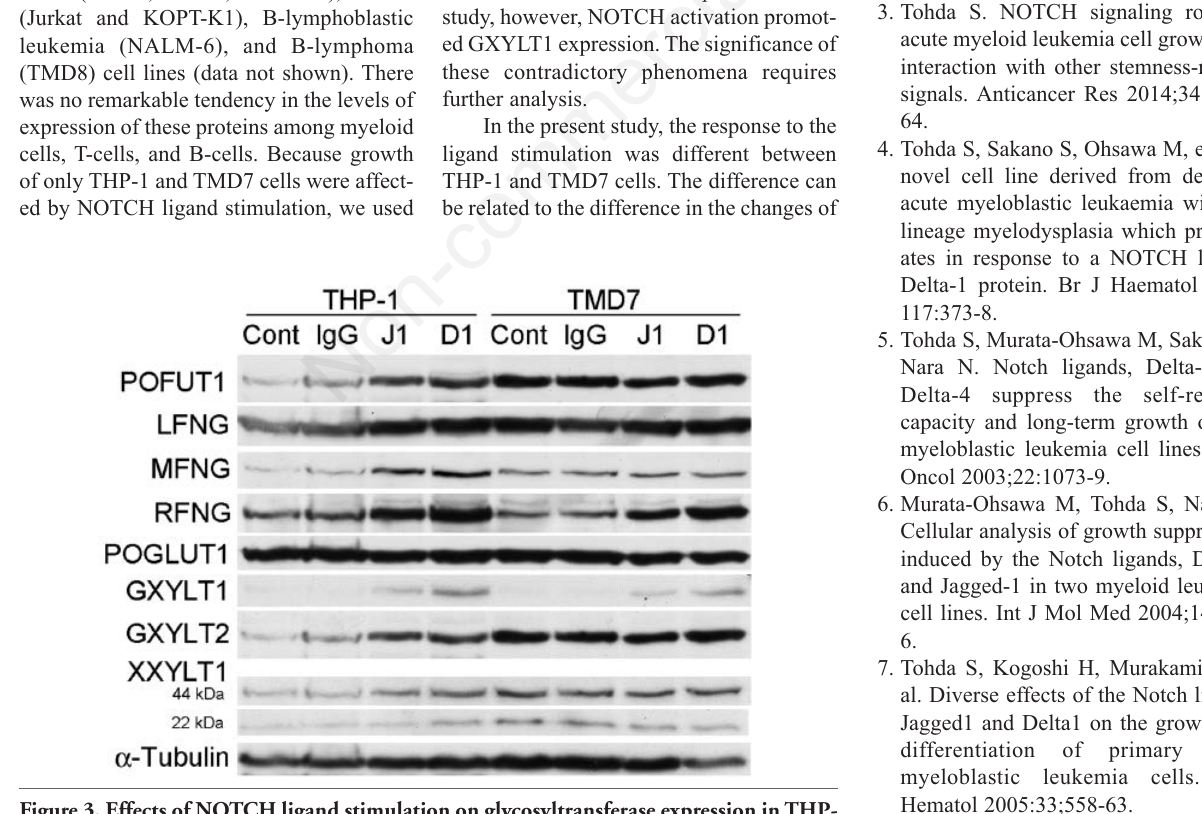
Figure 3. Effects of NOTCH ligand stimulation on glycosyltransferase expression in THP- 1 and TMD7 cells. Cells were cultured in the absence (Cont) or presence of human IgG, JAGGED1 (J1), or DELTA1 (D1). After 24 h, cells were harvested, and lysates were sub- jected to immunoblot analysis using the indicated